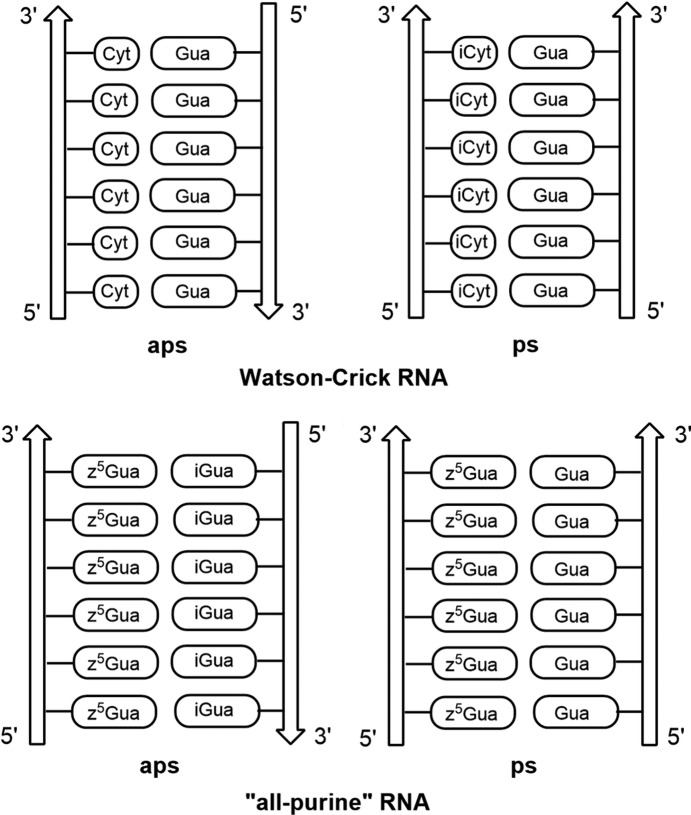
Illustration of RNA duplexes with pyrimidine–purine and purine–purine pairs with (a)/(c) anti­parallel-stranded (aps) and (b)/(d) parallel-stranded (ps) orientations. Notes: Cyt = cytosine, Gua = guanine, iCyt = isocytosine, z5Gua = 5-aza-7-de­aza­guanine and iGua = isoguanine.